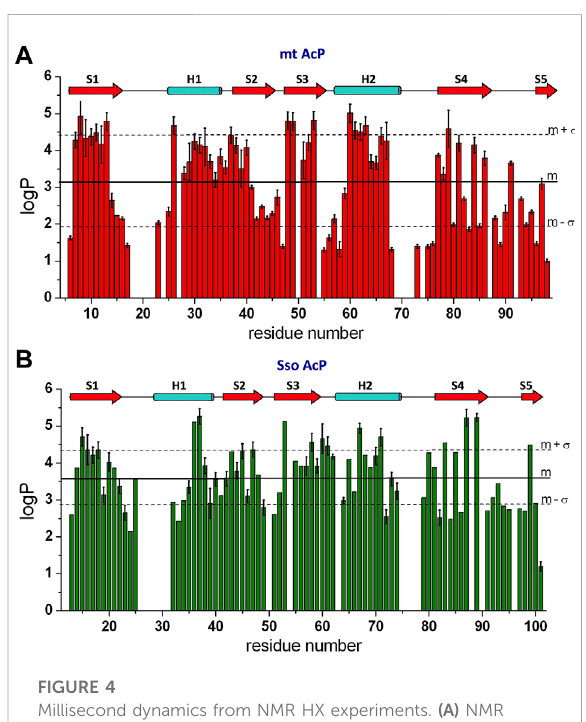
FIGURE 4 Millisecond dynamics from NMR HX experiments. (A) NMR HX data of mt AcP at 37 ° C elaborated as logP values. Error bars are derived from the fi tting standard deviation of the raw exchange NMR data. (B) NMR HX data of Sso AcP at 80 °